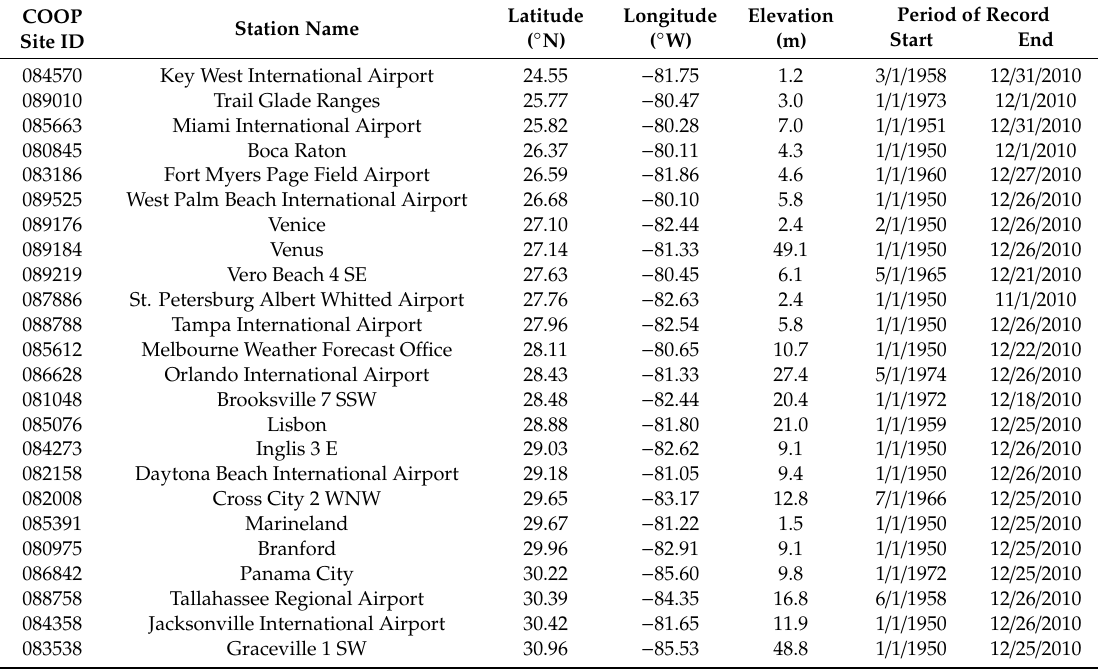
Table 1. Summary of the 24 rainfall gauging stations located across